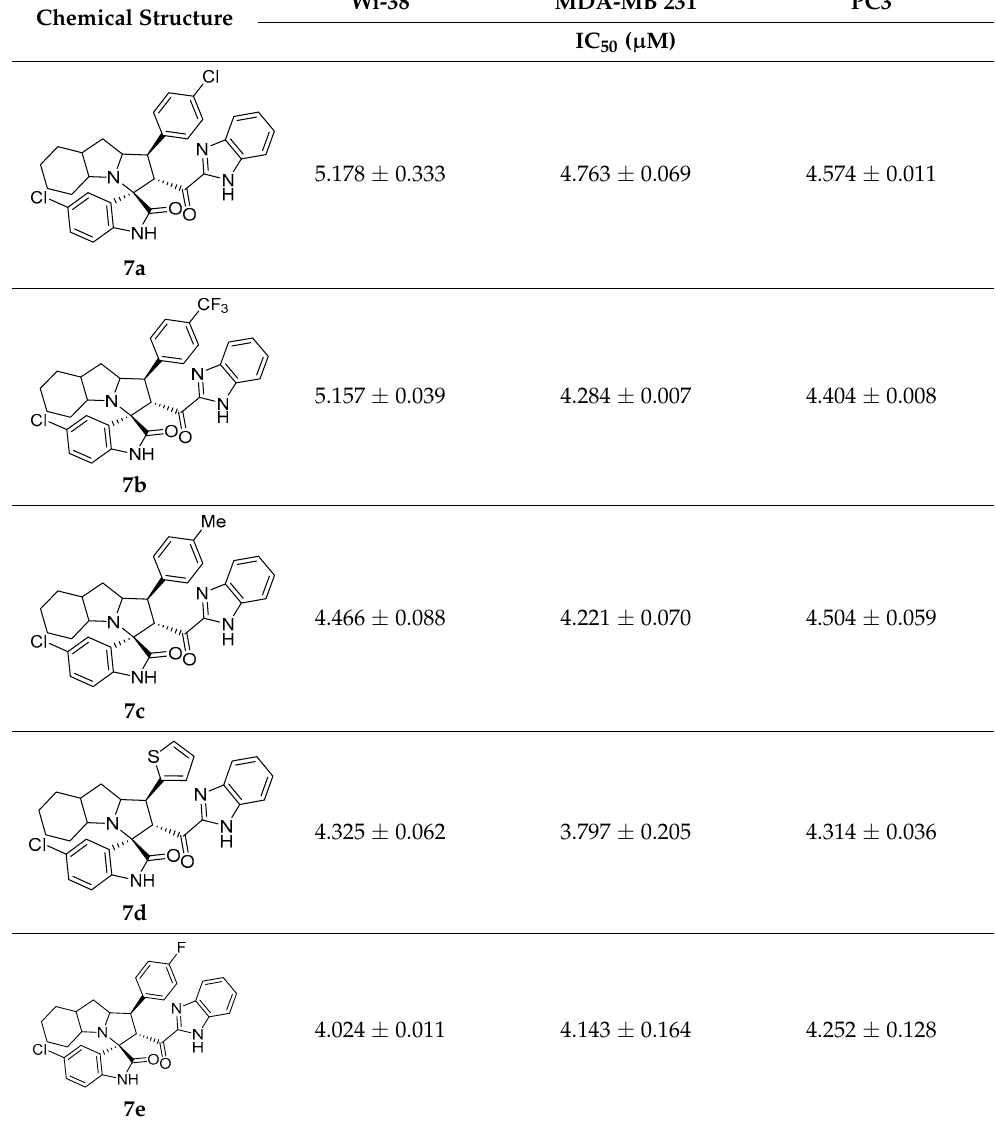
Table 1. The estimated IC 50 ( µ M) of 7a-o on Wi-38 viability, the growth of MDA-MB 231, and Table 1. The estimated IC 50 (µM) of 7a-o on Wi-38 viability, the growth of MDA-MB 231, and PC3 Table 1. The estimated IC 50 (µM) of 7a-o on Wi-38 viability, the growth of MDA-MB 231, and PC3 PC3 cells. Table 1. The estimated IC 50 (µM) of 7a-o on Wi-38 viability, the growth of MDA-MB 231, and PC3 cells . Table 1. The estimated IC 50 (µM) of 7a-o on Wi-38 viability, the growth of MDA-MB 231, and PC3 cells . Table 1. The estimated IC 50 (µM) of 7a-o on Wi-38 viability, the growth of MDA-MB 231, and PC3 cells . cells . cells